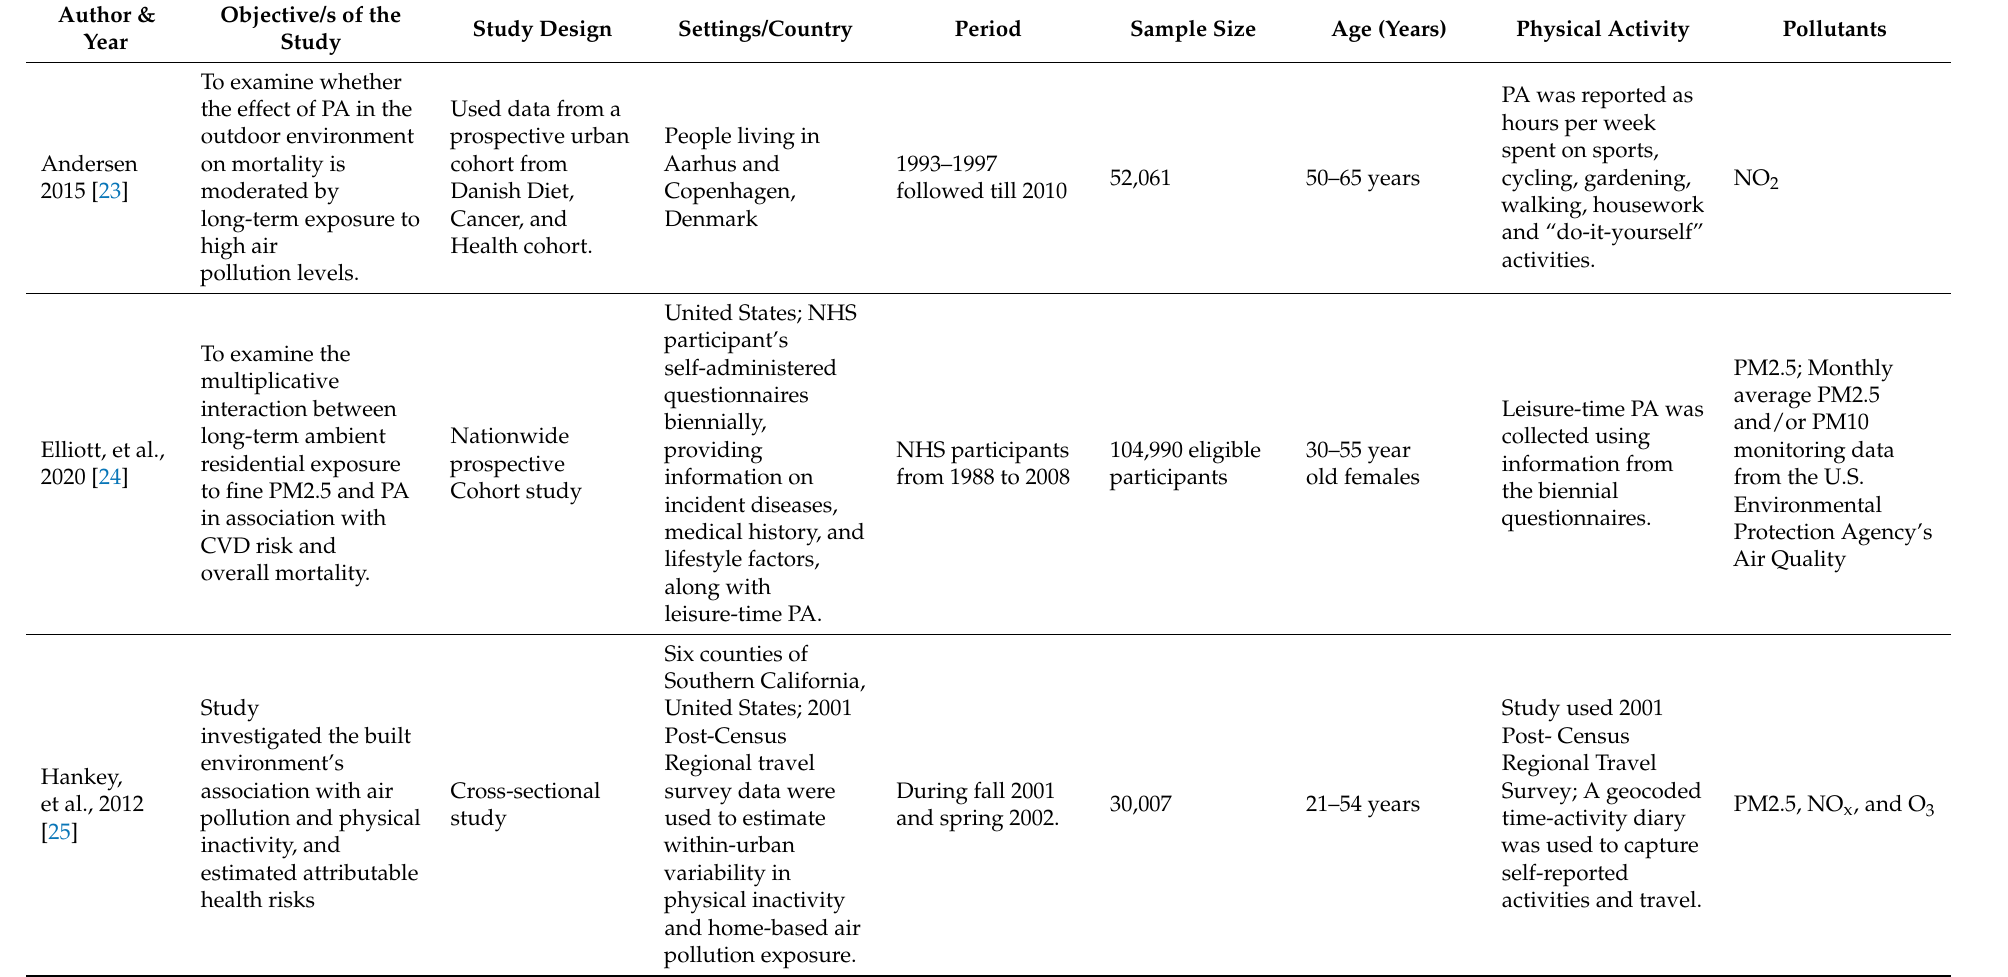
Table 1. Characteristics of the included studies ( n =